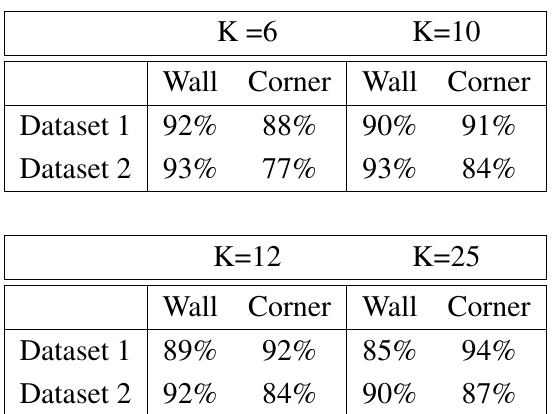
Table 2. Classification algorithm KNN results for different values of K. (Distances less than 4m, for all incidence angles). As it can be seen, best results are obtained for K = 10